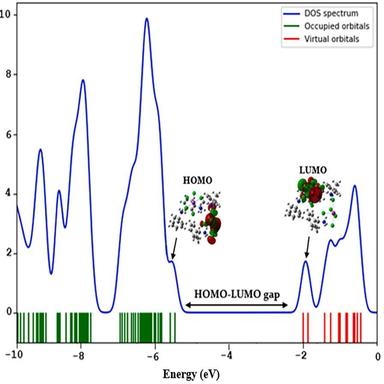
Density of state (DOS) spectrum of (C8H12N)42.